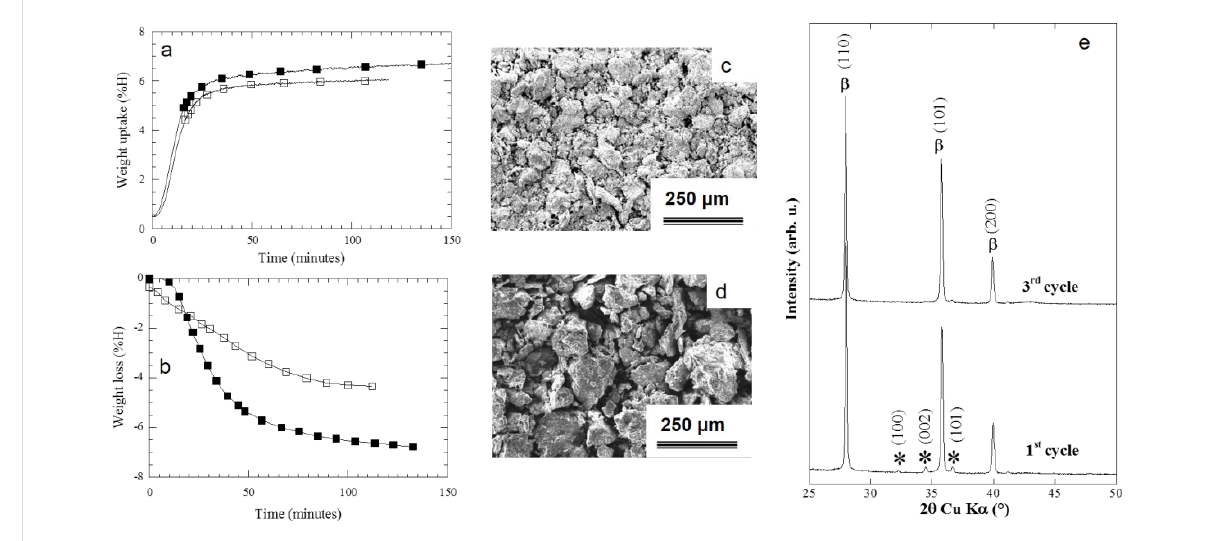
Figure 13: a) Absorption and b) desorption kinetics at 350 °C for Mg–10%C 10 , 320 composite (open squares): first cycle, black squares: third cycle; c) SEM image of the MgH 2 powder after one absorption; d) SEM image of the MgH 2 powder after three absorptions; e) XRD patterns of the MgH 2 powder after one and after three absorptions [11].